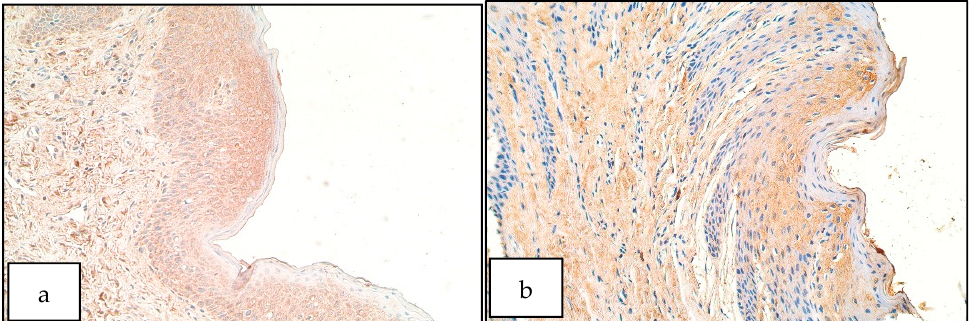
Figure 7. Immunoreactive structures for WNT3A. ( a ) Moderate to numerous WNT3A positive structures in the patient epithelium and moderate number of WNT3A positive structures in the connective tissue, WNT3A IMH, 200×. ( b ) Moderate number of WNT3A positive structures in the control epithelium, WNT3A IMH, 200×.